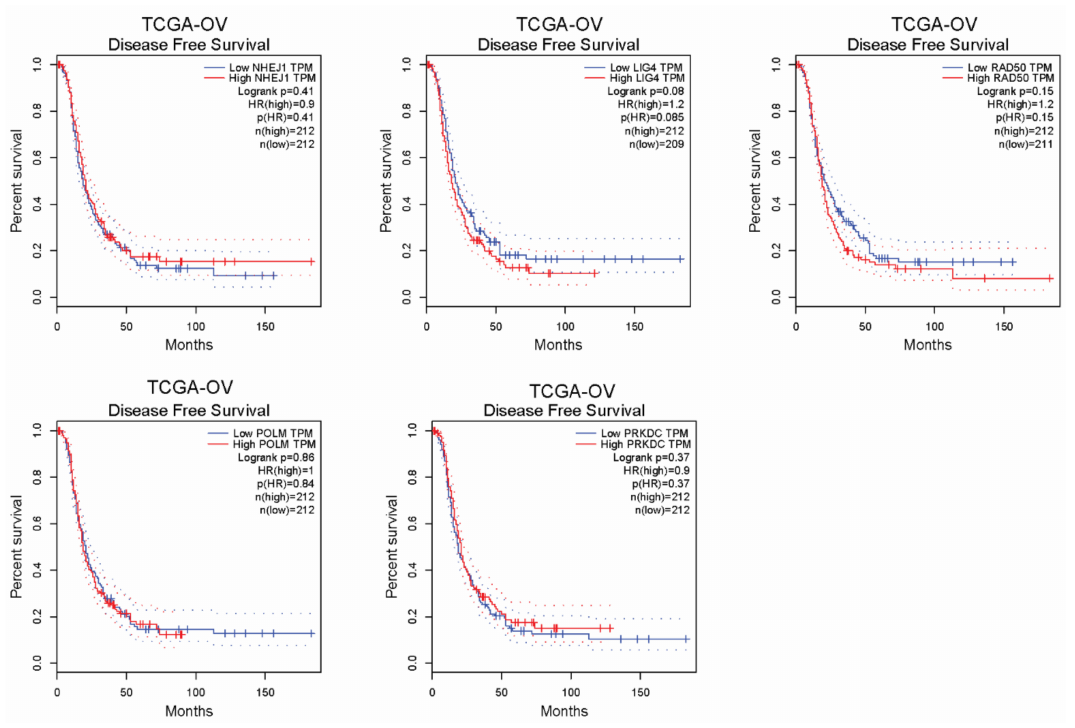
Figure A1. The correlation of genes in the NHEJ pathway with disease-free survival of ovarian cancer patients in TCGA database.